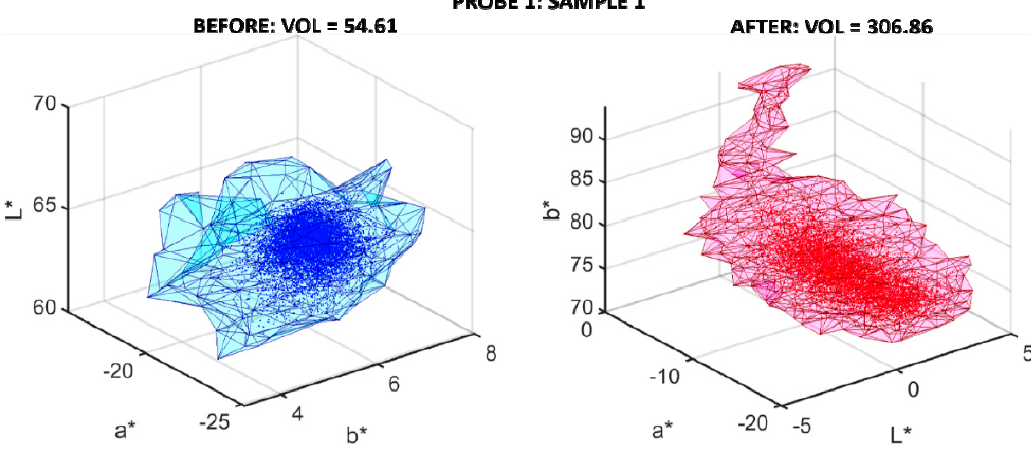
Figure 7. Minimum volume of the L* , a* , b* clouds of sample 1 of probe 1 before ( left ) and after ( right ) cleaning. Table 4. Standard deviation of the spectral reflectances (mean across all wavelengths) and the L* , a* , b* color coordinates, and L* , a* , b* clouds volumes before and after cleaning for all the samples.